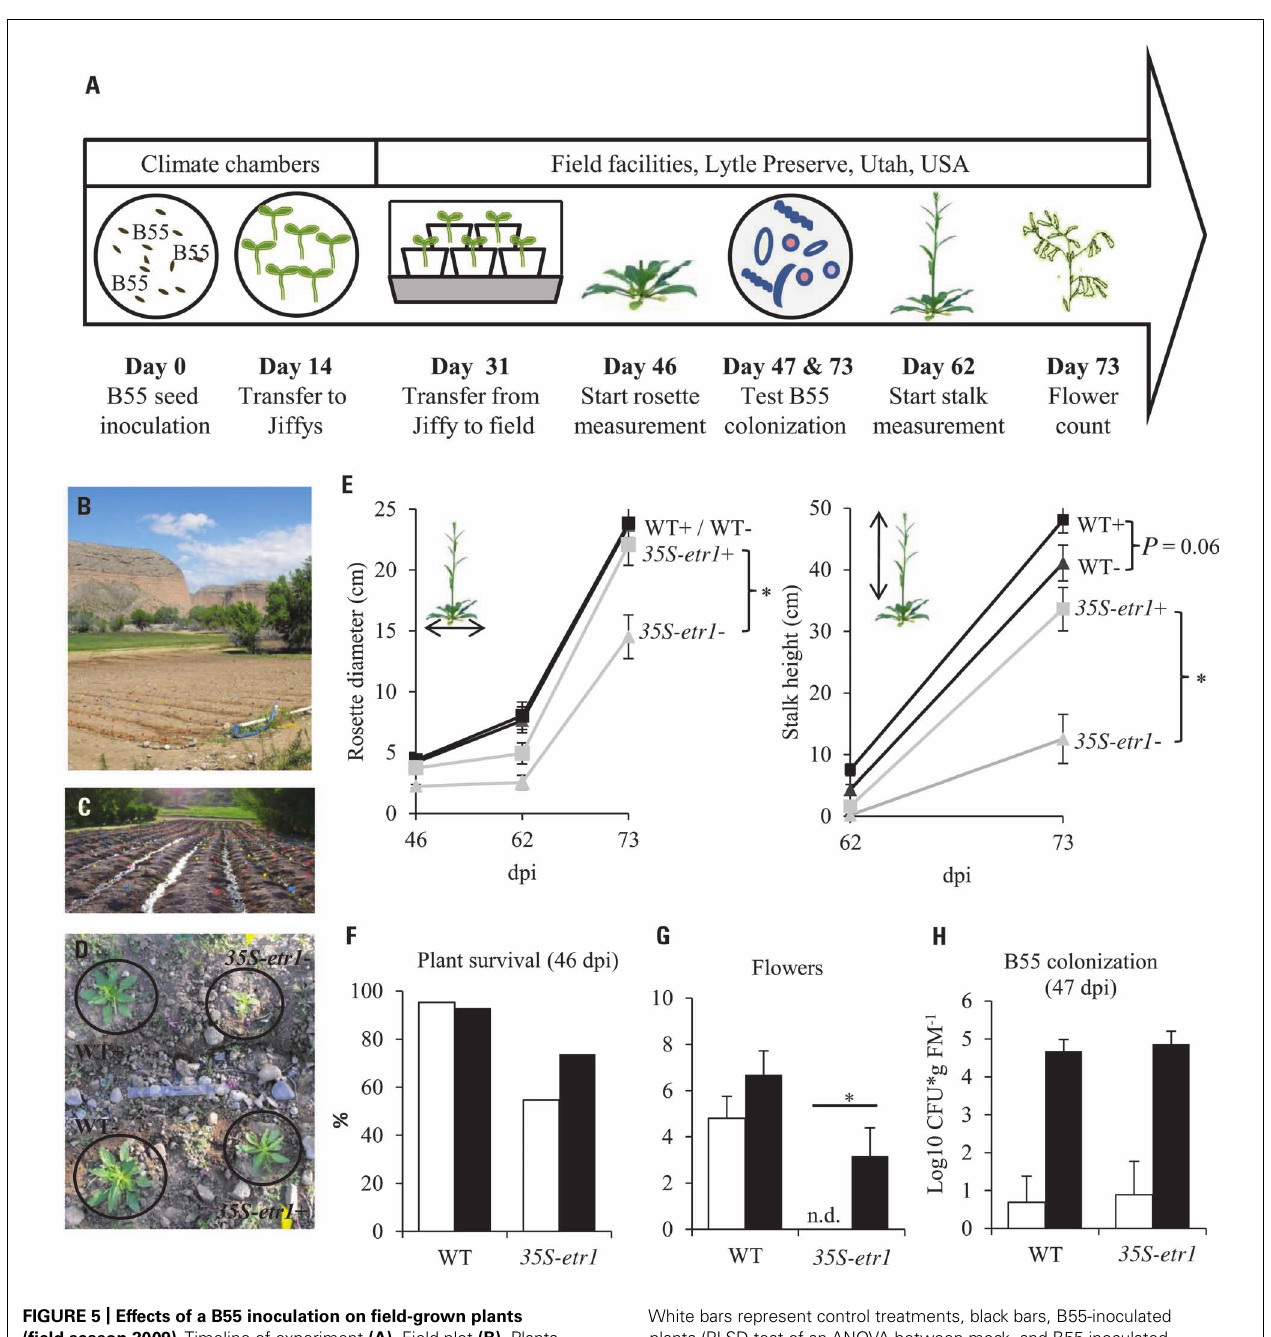
FIGURE 5 | Effects of a B55 inoculation on field-grown plants (field season 2009). Timeline of experiment (A) . Field plot (B) . Plants were planted in rows separated by water channels (C) , mock- and B55-inoculatedWT and 35S-etr1 plants were planted in a quadruplets in a randomized design (D) . Mean ( ± SE) rosette diameter and stalk height (E) , survivorship (F) , flower number (G) , and B55 colonization (H) .